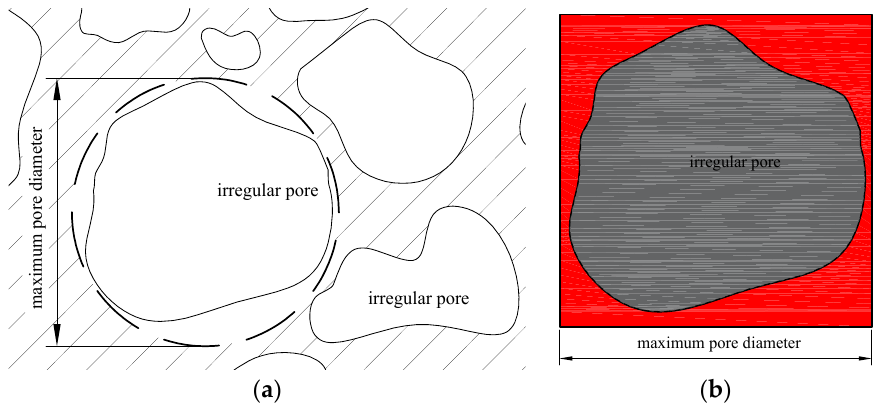
Figure 11. Schematic diagram of the maximum pore and the box cover: ( a ) the maximum pore area; ( b ) the actual edge length.